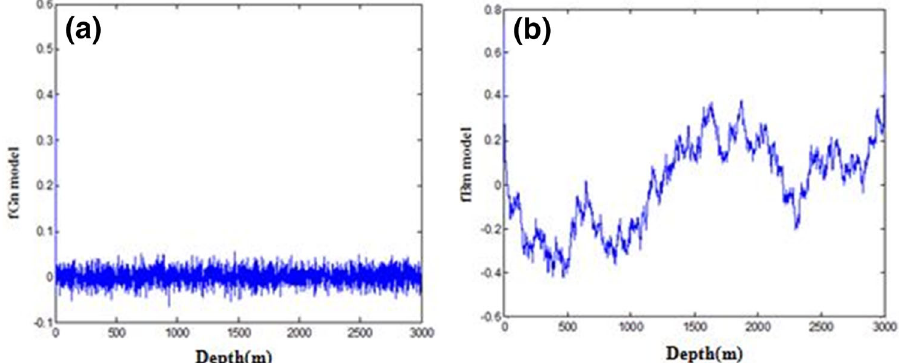
Fig. 9 Two realizations with fractal structure for core porosity in well C; ( H =